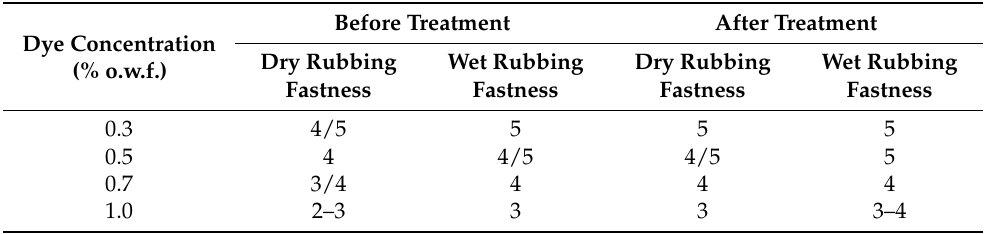
Table 3. Effect of existence of oligomers on colorfastness properties of fabric dyed in waterless dyeing system.